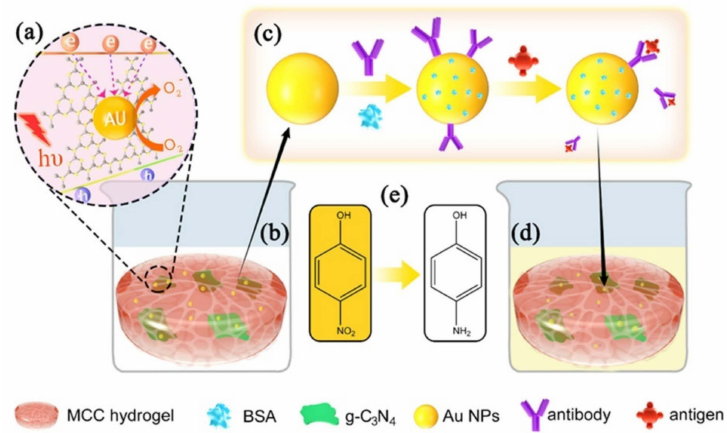
Figure 8. ( a ) Mechanism of the electron transfer between g-C 3 N 4 and Au NPs, ( b ) color of 4- nitrophenol was faded almost completely at the 40th minute catalyzed by Au@g-C 3 N 4 /MCC, ( c ) incubation process of antibody/antigen with Au@g-C 3 N 4 /MCC, ( d ) color of 4-nitrophenol was faded partly at the 40th minute catalyzed by incubated Au@g-C 3 N 4 /MCC, ( e ) color and structure of 4-nitrophenol (yellow) and 4-AP (colorless) [79]. Copyright 2019, American Chemical